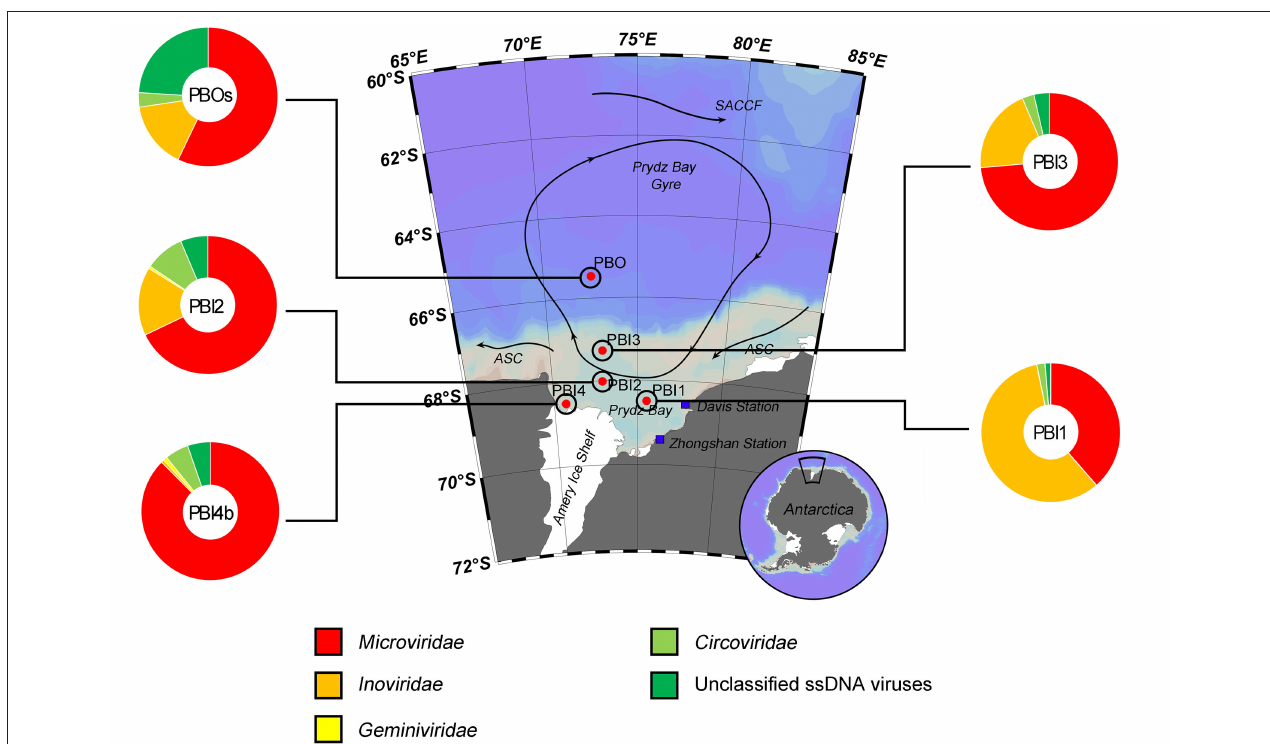
FIGURE 3 | Taxonomic composition of annotated ssDNA viromes in the Prydz Bay, Antarctic. The pie charts show a global representation of ssDNA viral groups for five samples (except PBI4s and PBOb) from the Prydz Bay. Different colors refer to different viral groups showed in the legend on the